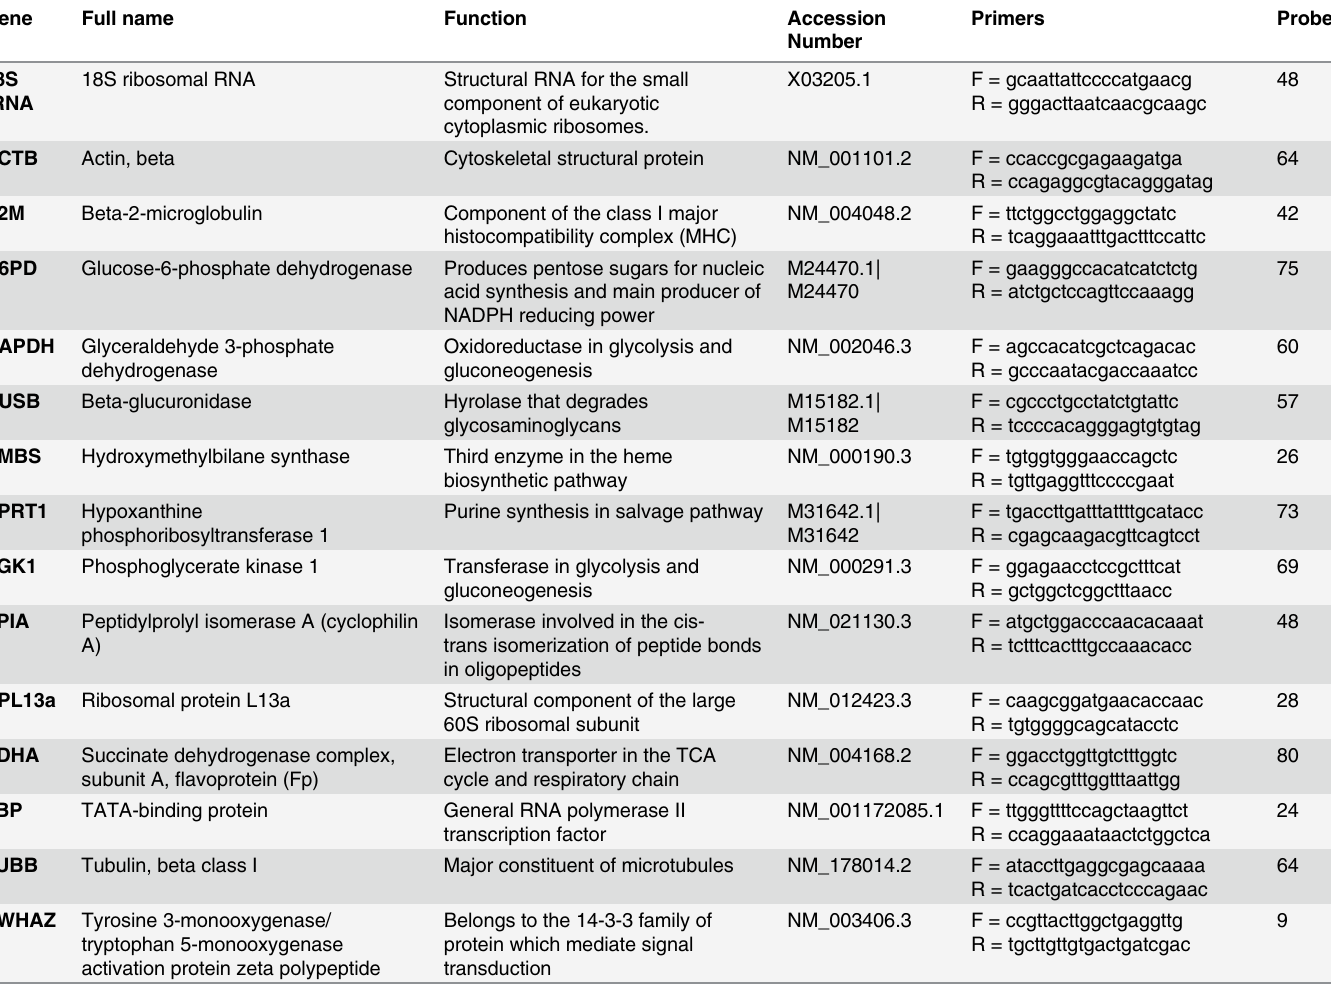
Table 1. Candidate HKG